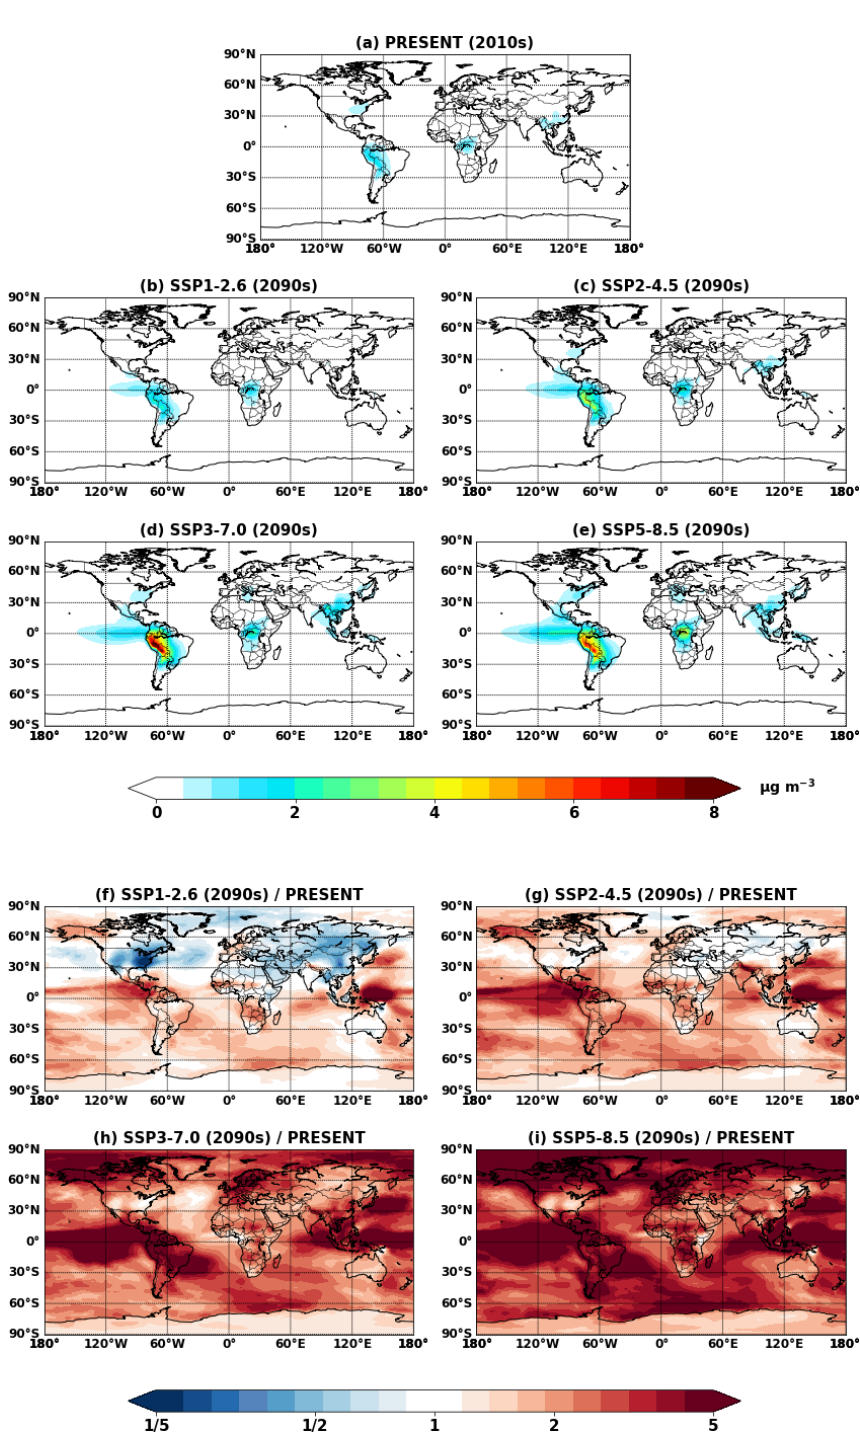
Figure 7. Global mean IEPOX SOA concentrations at the surface simulated in (a) Explicit_SS_2010 and (b–e) Explicit_ SS_ 2090_SSPx. (f–i) Ratios of IEPOX SOA between future (b–e) and present (a)